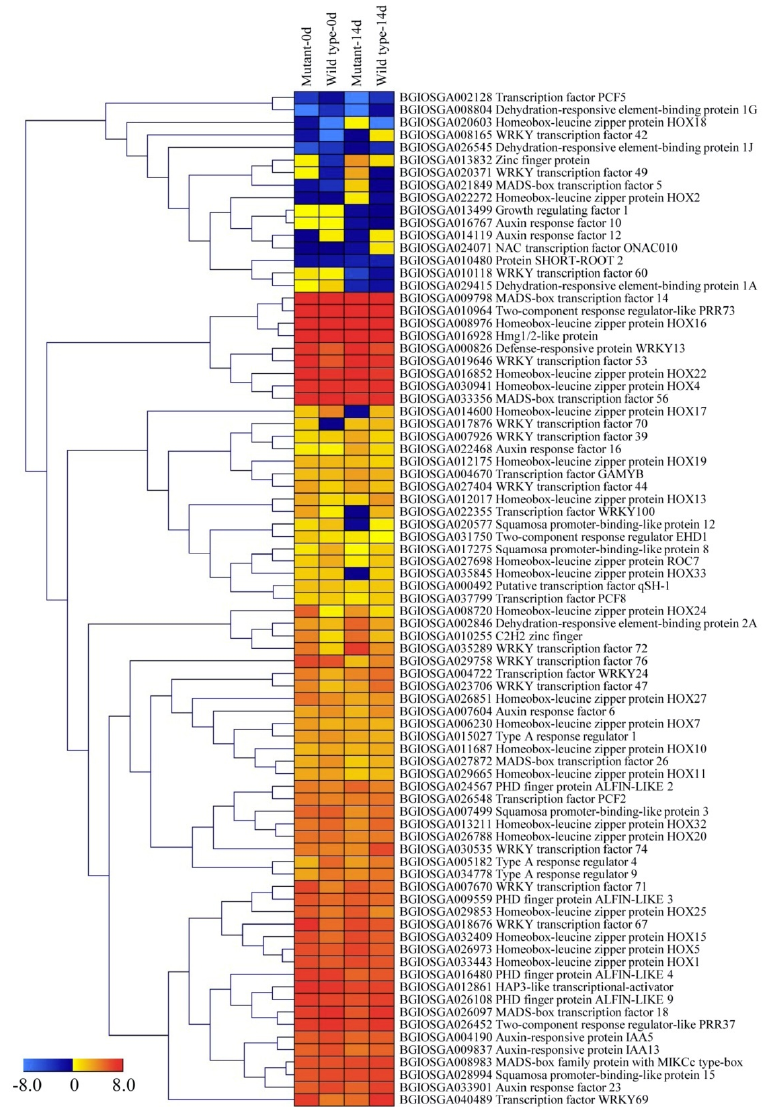
Figure 6. Hierarchical cluster analysis of TFs identified in DEGs in the two rice genotypes. Genes were displayed by different colors. Relative levels of expression were shown by a color gradient from low (blue) to high (red).